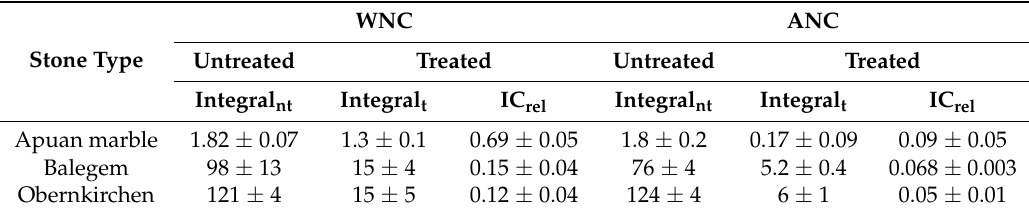
Table 8. Absorption integrals (in g ⋅ cm − 2 ⋅ s 0.5 ) of untreated (integral nt ) vs. treated (integral t ) lithotypes and IC rel values (= integral t /integral nt ).